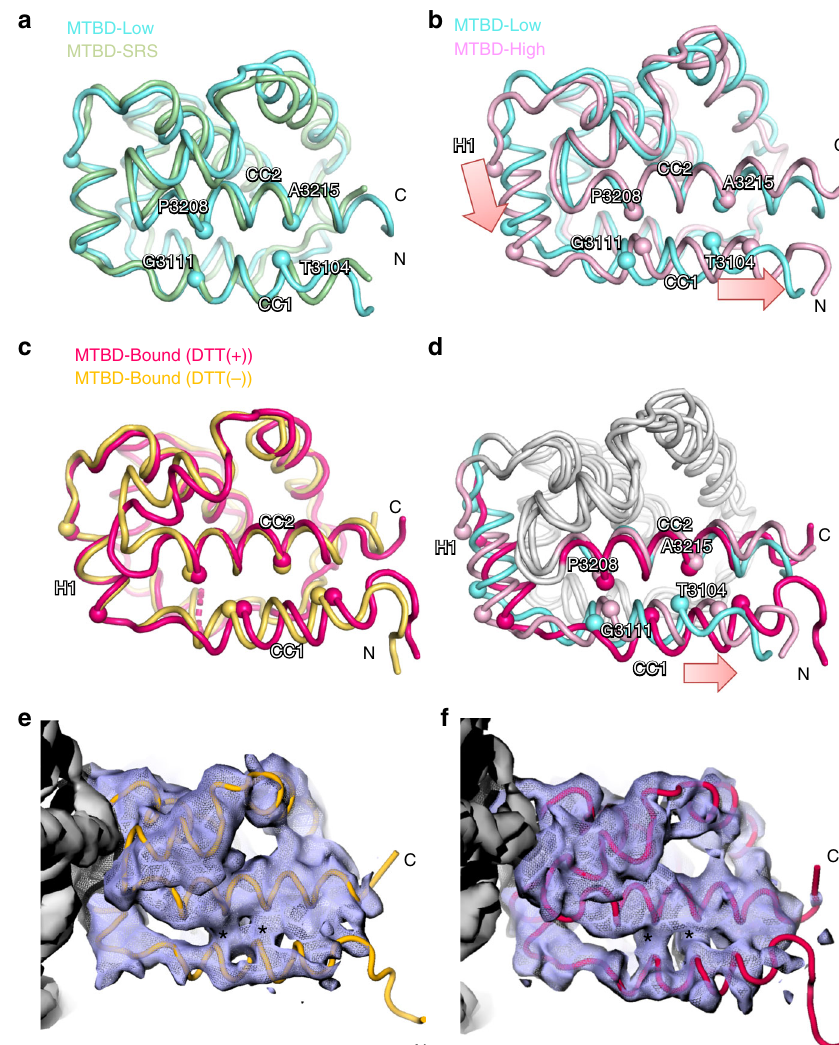
Fig. 2 Structure comparison of MTBD-High, MTBD-Low and MTBD in complex with MT. a Superposition of MTBD-Low (cyan) and mouse MTBD SRS chimera (PDB code 3EER, light green) viewed from the side. b Superposition of MTBD-High (pink) and MTBD-Low (cyan). c Superposition of cryo-EM model of MTBD in complex with MTs in the DTT( − ) (orange) and DTT( + ) (magenta) conditions. d The superposition of MTBD-Low (cyan), MTBD-High (pink), and MTBD-Bound (magenta). Only the CC1, H1, and CC2 moieties are colored. The C α positions of CC1 and CC2 residues that signify the coiled-coil registry are shown by spheres. The notable conformational changes of H1 and CC1 are indicated by pink arrows. e , f Superposition of the cryo-EM map fi ltered to 4 Å and the model of MTBD in complex with MTs in ( e ) DTT( − ) (yellow) and in ( f ) DTT( + ) (magenta) conditions. Asterisks (*) are placed on the regions corresponding to the hydrophobic interactions between CC1 and CC2 in both